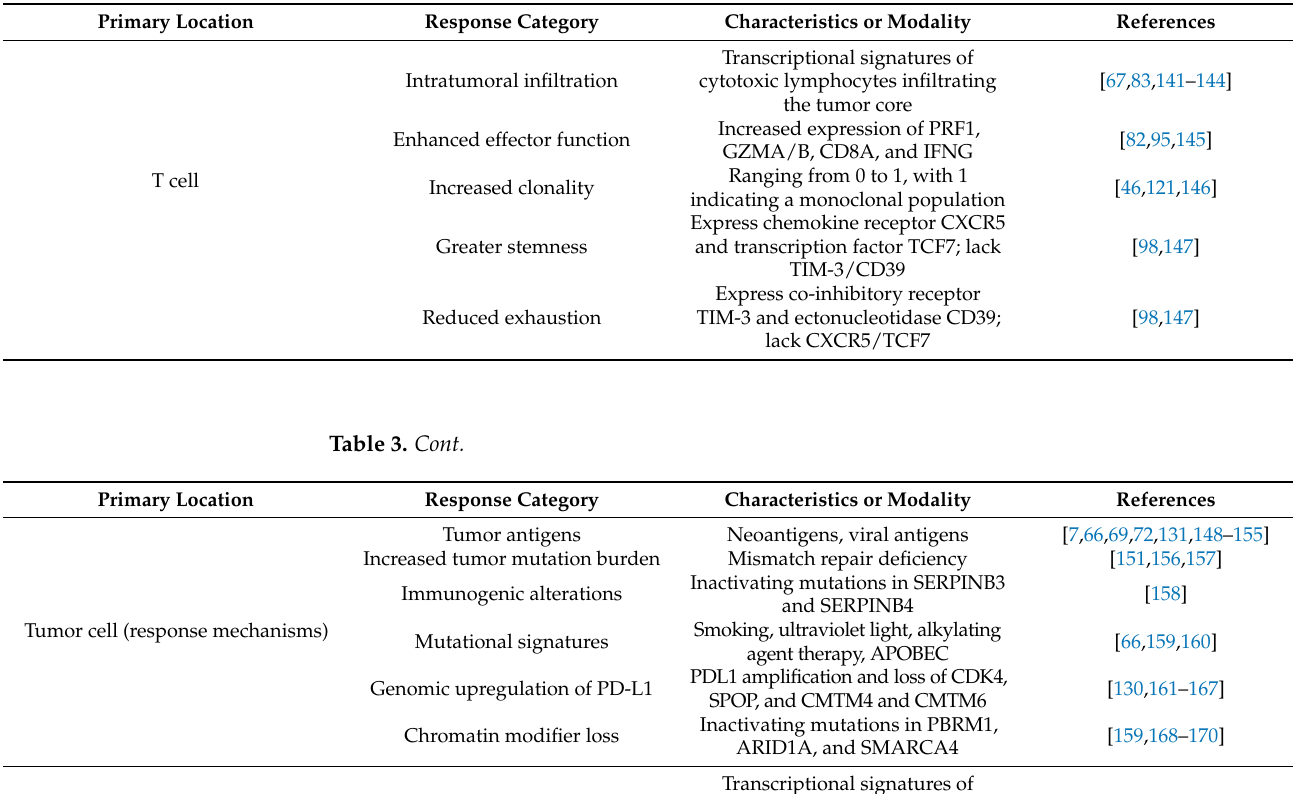
Table 3. Genomic correlations with response and resistance based on primary location.